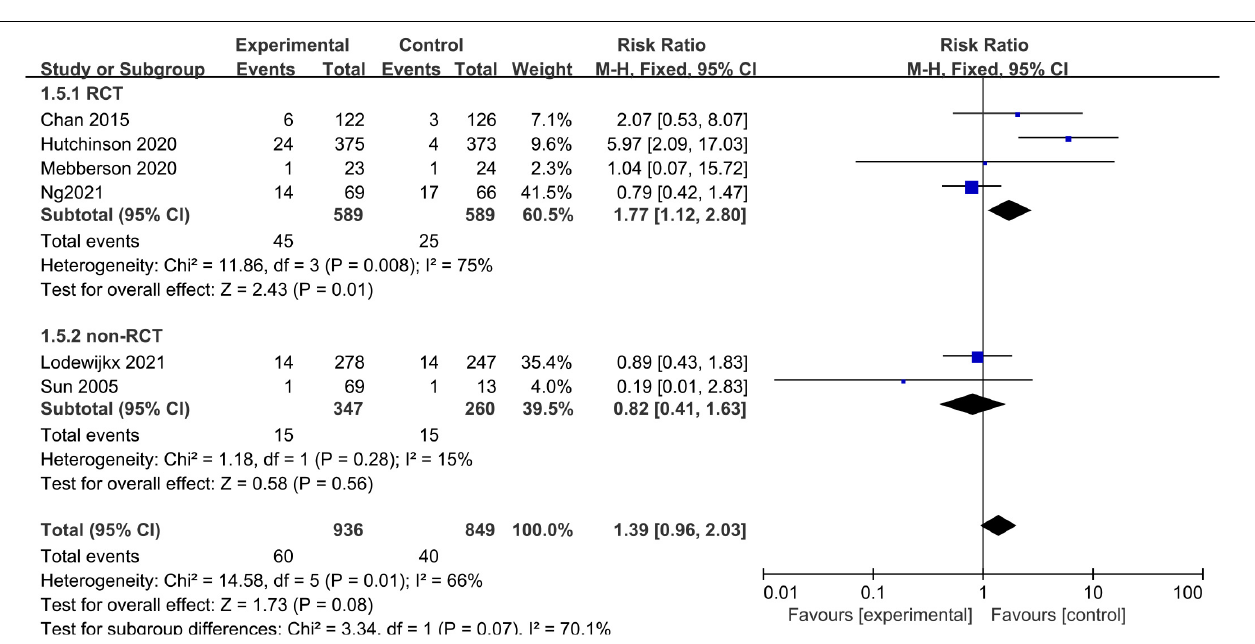
FIGURE 6 | Meta-analysis of adjuvant corticosteroid group compared to the surgery alone group on infections.